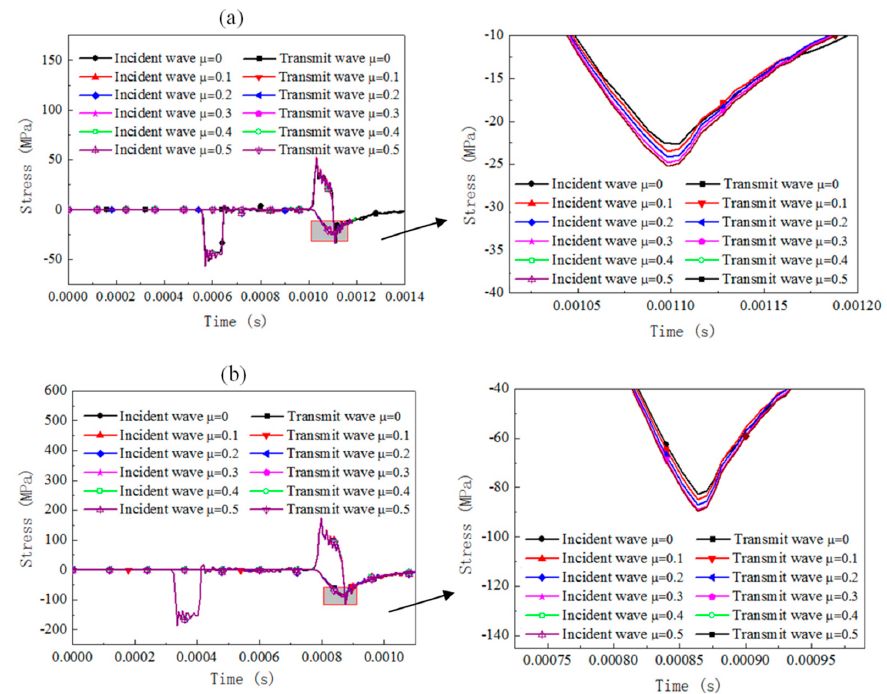
Figure 5. Comparison of the reflected and transmitted waves under different friction conditions and initial impact velocities for rate-independent material (cylinder specimen with slenderness 0.66). ( a ) Impact velocity of 3 m/s, ( b ) impact velocity of 10 m/s.